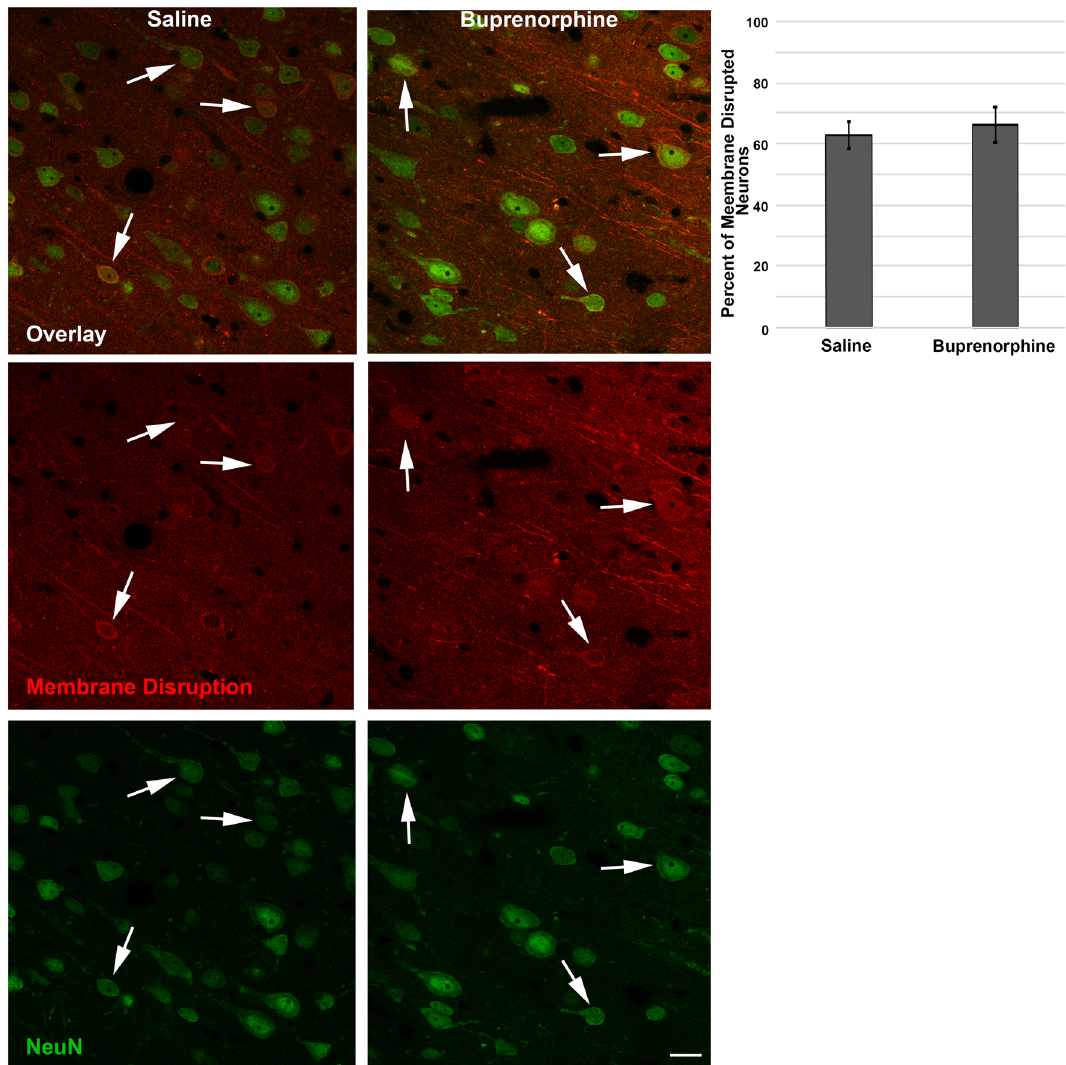
Figure 4. Acute neuronal membrane disruption was not altered in the cortex of Bup-treated animals. Representative photomicrographs of sub-acute neuronal membrane disruption in the lateral neocortex of rats treated with saline or buprenorphine. Prior to sacrifice at 1d post-injury rats were infused with a 10 kDa cell-impermeable, biotinylated dextran. NeuN + neurons are green (single channel images in bottom images) and dextran-containing membrane disrupted neurons are pseudocolored red (single channel images in middle images). Brain sections were incubated with goat anti-biotin primary antibody followed by Alexa-568- conjugated donkey anti-goat secondary antibodies to visualized cells that contained dextrans for the assessment of neuronal membrane disruption (arrows) in the lateral neocortex layers V and VI. Corresponding bar graph depicting the percentage of total neurons that showed disruption in saline and buprenorphine treated animals. The percentage of dextran + neurons was consistent between groups, indicating that buprenorphine treatment did not affect the percentage of membrane disrupted neurons in the cortex. Figure was compiled using Adobe Photoshop CS., version 22.0 (2020), San Diego, CA. n = 6 rats/group. Mean ± SEM. Scale = 20